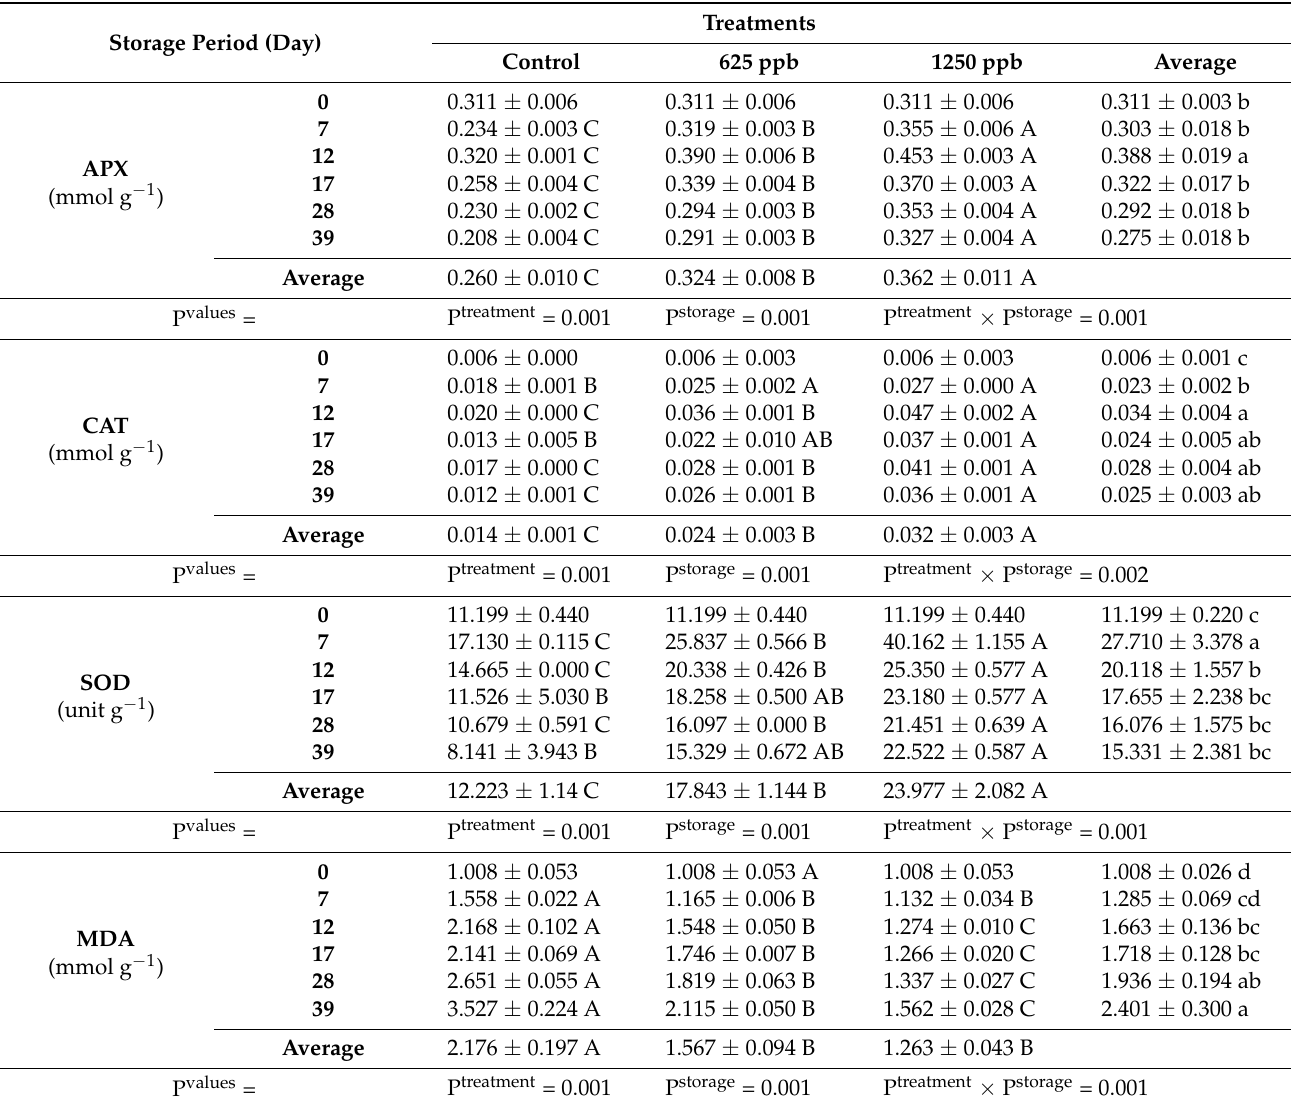
Table 4. The APX, CAT, SOD, and MDA during storage of ‘Seyit F1’ cocktail tomato (